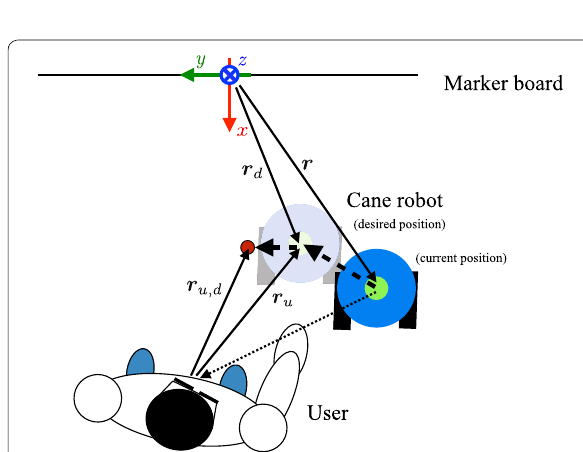
Fig. 5 Coordinate system of the cane robot and the user. The cane robot detects the position and orientation of the landmark (AR marker). Based on this estimation, the robot and user’s positions with respect to the landmark can be